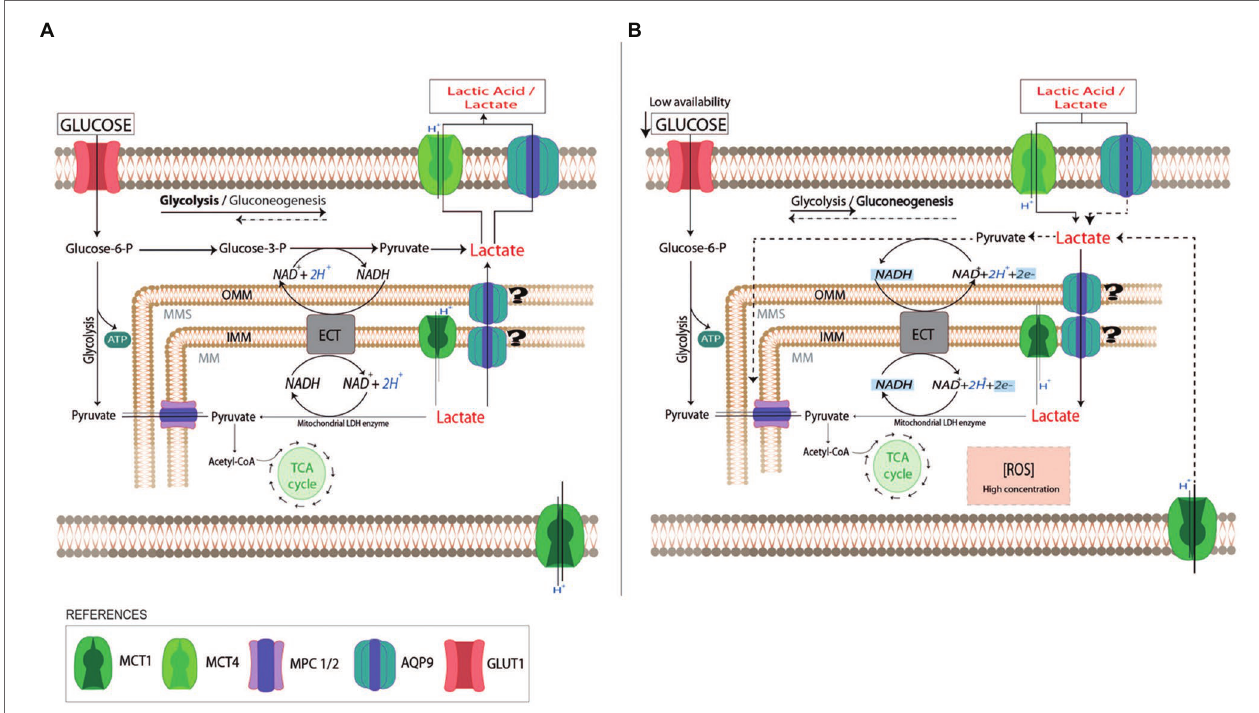
FIGURE 5 | Schematic representation of lactate use by trophoblast cells. In normal pregnancies, trophoblast cells use glucose as a fuel to support the placenta’s cellular growth (A) . The excess of lactate due to fetal metabolism may be driven into the maternal circulation by monocarboxylate transports system (MCTs) and AQP9. When the availability of glucose is reduced (B) , trophoblast cells can use lactate as a carbon source substitute (dot lines). The uptake of lactate into the cytosol may be facilitated by AQP9 and MCTs localized in the plasma membrane. In the cytosol, lactate can be metabolized into pyruvate or it can pass across the external and inner mitochondria membranes by MCTs or AQP9. In the mitochondria matrix, lactate may be oxidated to pyruvate by a mitochondrial LDH while NAD + is reduced to NADH. The produced NADH may act as a reactive oxygen species scavenger. In preeclamptic placentas, AQP9 is not functional altering the use of lactate by the trophoblast cells. This may affect the mitochondria function, leading to the activation of the mitochondrial pathway of apoptosis. OMM, Outer Mitochondria membrane; IMM, Inner Mitochondria membrane; ECT, Electron transport chain; TCA cycle, tricarboxylic acid cycle; and MPC 1/2, Mitochondrial pyruvate carrier 1 and